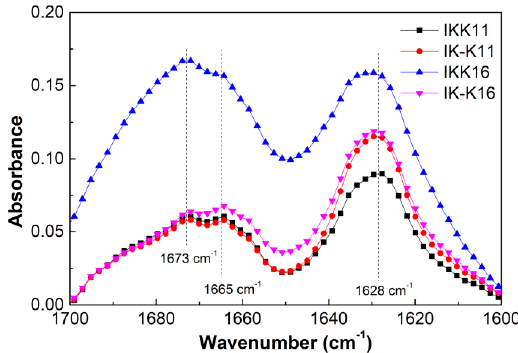
Figure 4. The amide I region of the FTIR spectra of different peptide solutions at concentration of 4.0 mM and temperature of 20 °C.